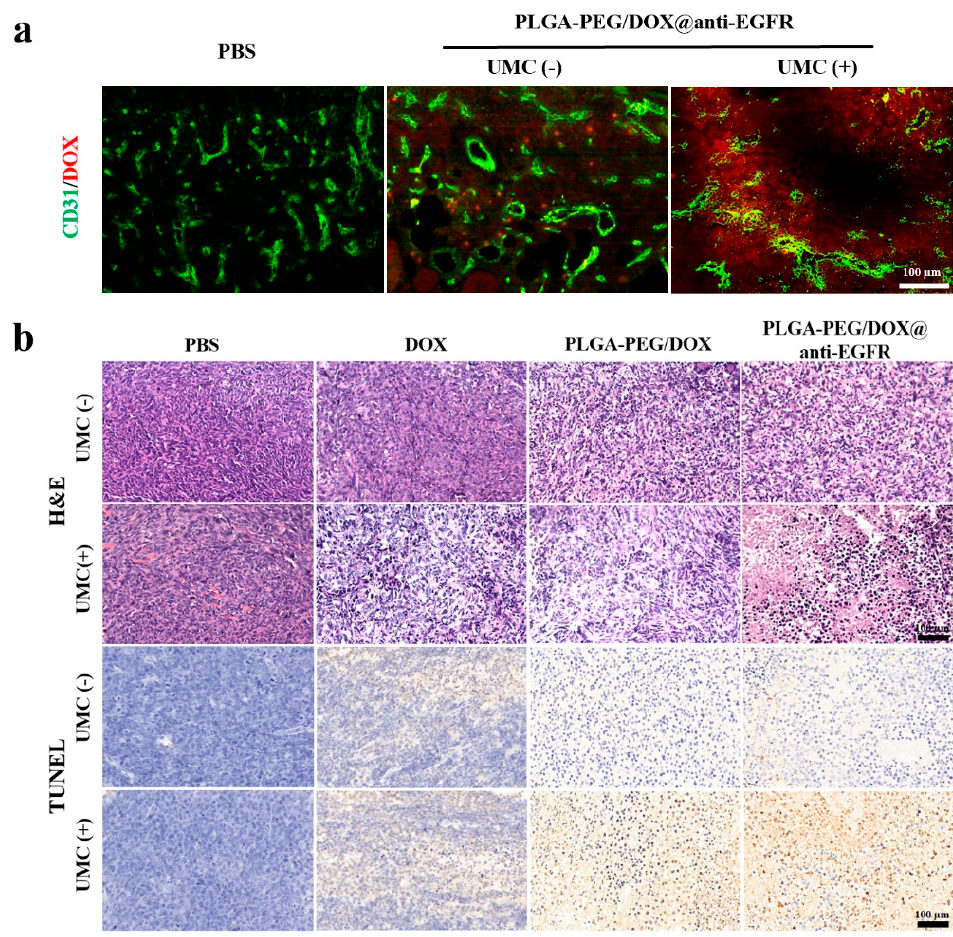
Figure 7. ( a ) DOX intra-tumoral penetration following intravenous PLGA-PEG@DOX/anti-EGFR injection with or without UMC. ( b ) H&E and TUNEL staining of MBA-MD-468 tumor samples in the indicated treatment groups. Scale bar: 100 µm. UMC(+) = with ultrasound-mediated cavitation, UMC( − ) = without ultrasound-mediated cavitation.